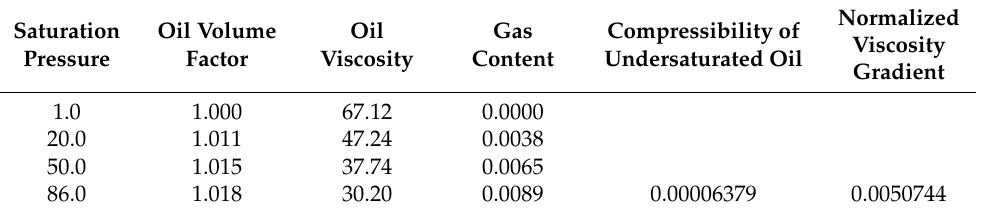
Table 2. PVT for oil (variant